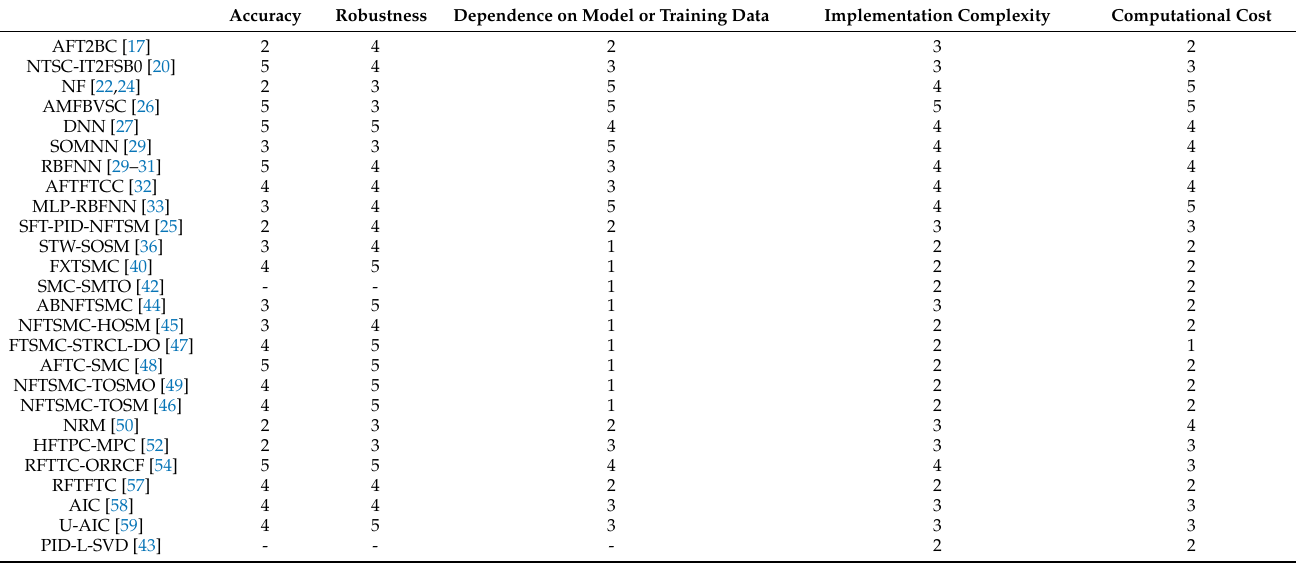
Table 1. Comparison of FTC methods used for robot control described in the cited